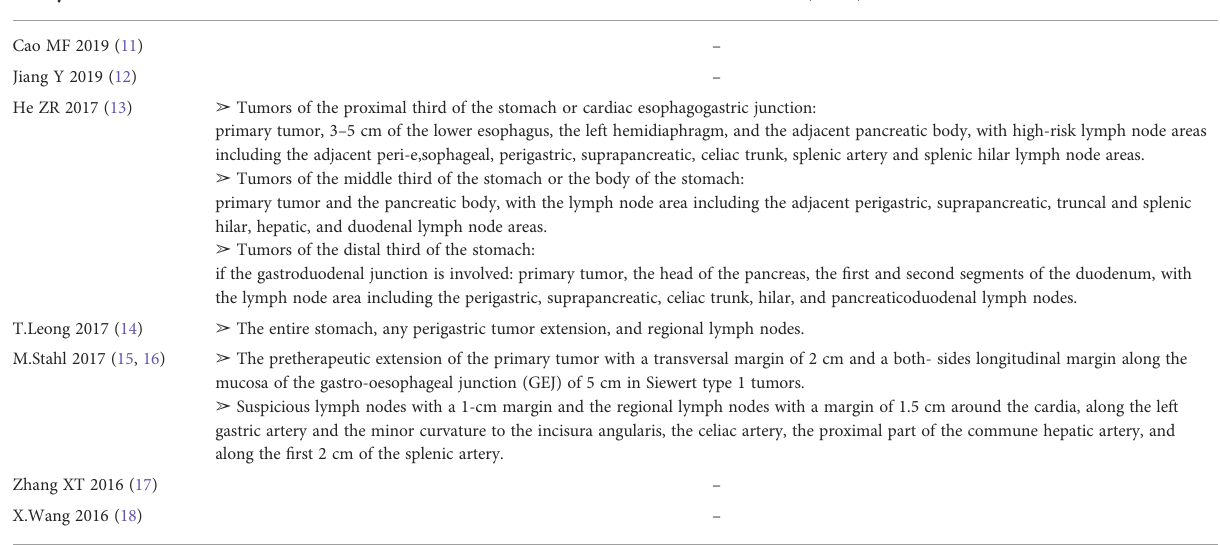
TABLE 3 The irradiation volumes of studies enrolled. Study